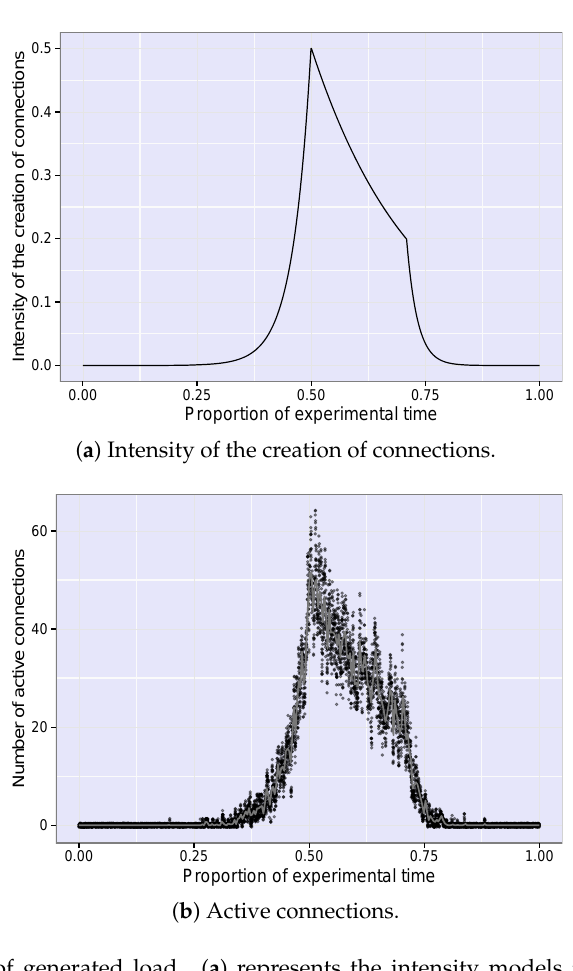
Figure 5. Analysis of generated load. ( a ) represents the intensity models for new connections; ( b ) represents the resulting connections: average activity in 5 min is displayed with a gray